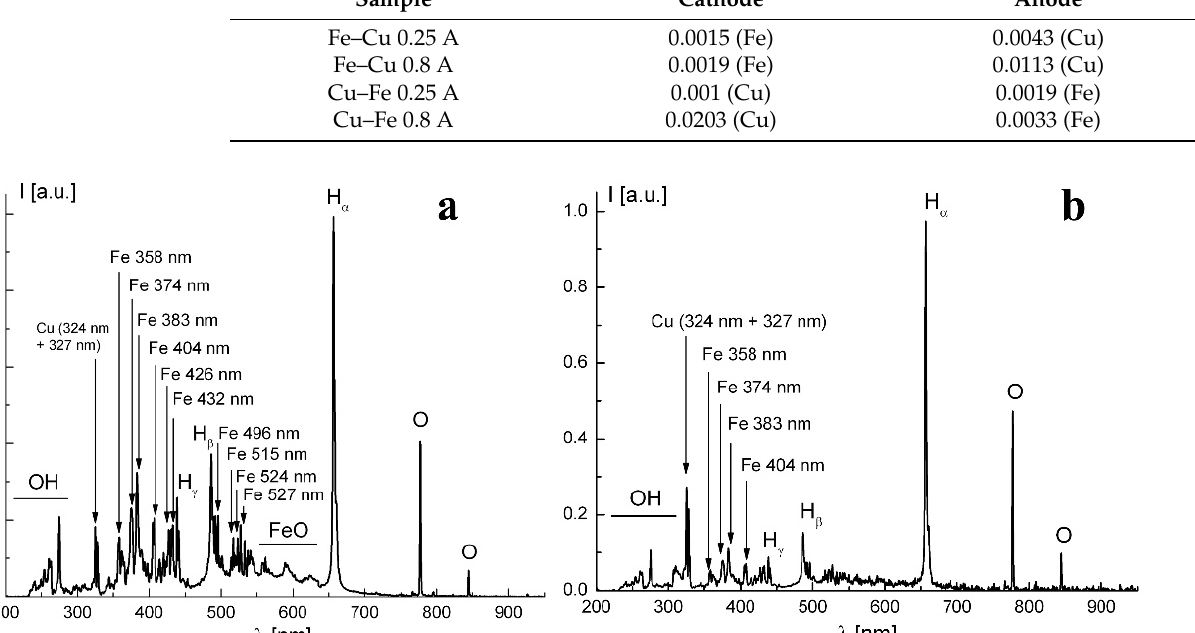
Table 2. Data of DLS analysis.